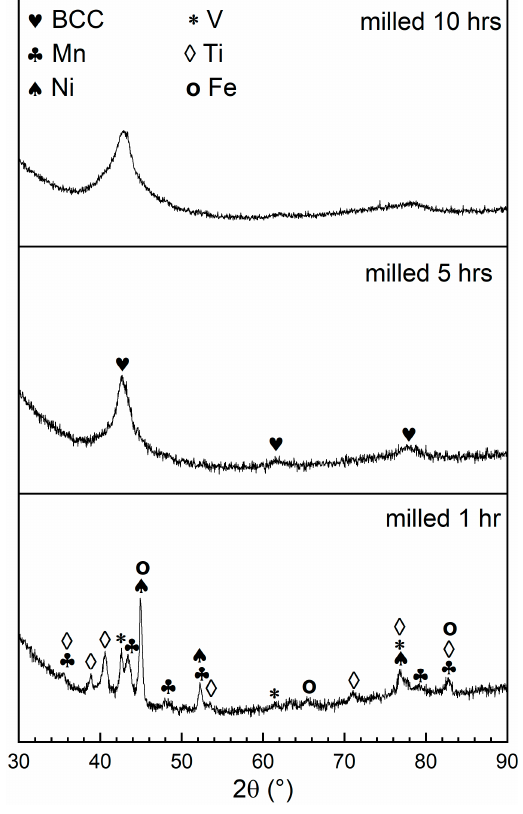
Figure 7. XRD patterns of Ti-V-Mn-Fe-Ni powders milled for 1, 5, and 10 hours. After one hour of milling, the Bragg peaks from all raw elements are still present. The five-hour milled pattern shows the formation of a BCC phase. Milling for 10 hours leads to further broadening of the BCC peaks. The diffraction patterns were analyzed by Rietveld’s refinement and the obtained crystal parameters of the BCC phase are shown in Table 6. Table 6. Crystal parameters of the BCC phase of the samples milled for 5 and 10 h. Error on the last significant digit is indicated in